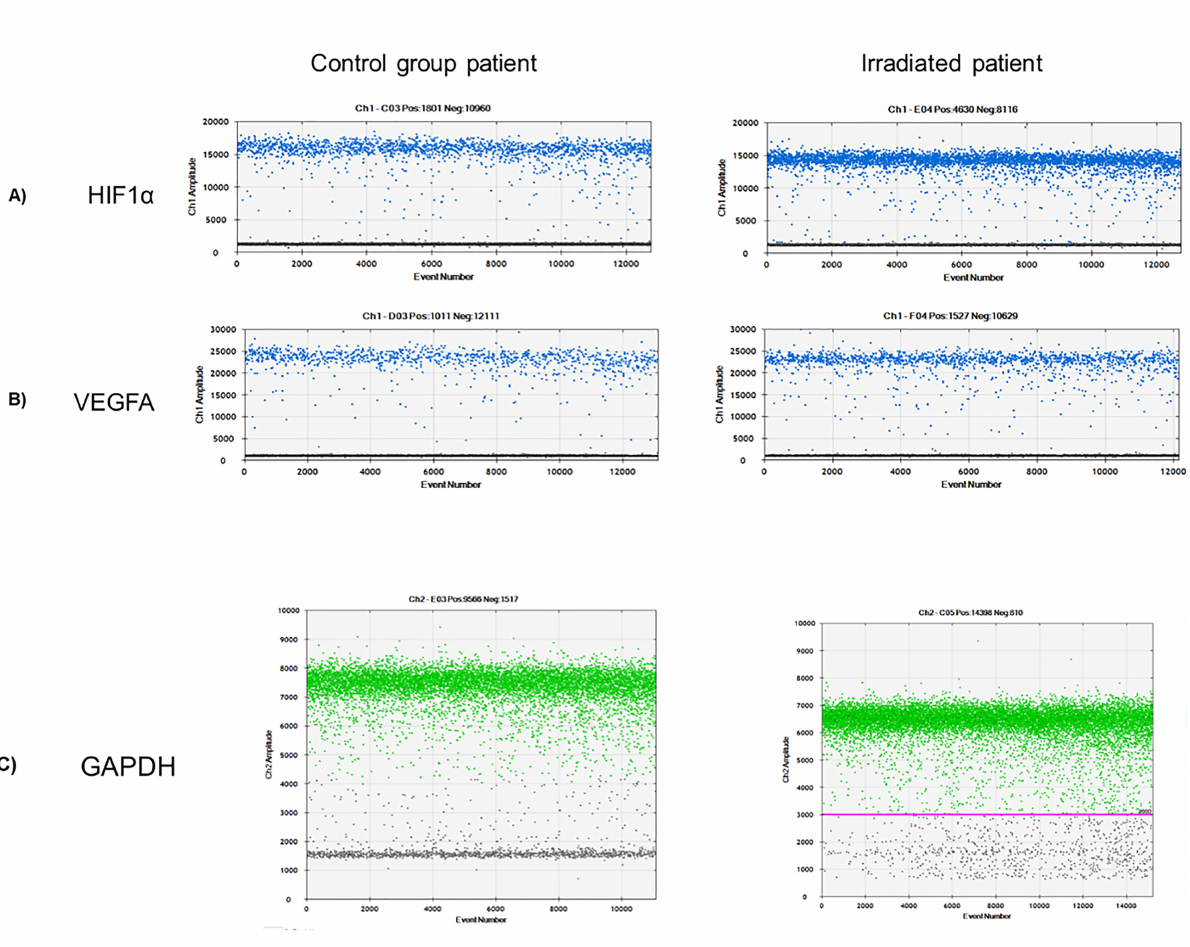
Figure 2 - Graphics of digital PCR in drops. The graphs indicate the fluorescence intensity (Ch1 Amplitude and Ch2 Amplitude for FAM or HEX, respectively) of the drops analyzed (events number). The drops are termed "positive" or "negative" based on their fluorescence amplitudes. Positive events are marked in blue (HIF-1 α and VEGF-A) and green (GAPDH), while negative events in gray (drops without the DNA molecule of interest). All analyzes were performed using QuantaSoft software (Bio- rad). During drop formation cDNA molecules are randomly distributed in the droplets. Due to the high number of independent events, the Poisson algorithm is used to determine absolute quantitation of copy number independent of a standard curve, allowing accurate quantification of gene expression. (A) Expression of HIF1 α in a control group patient (left) and in an irradiated patient (right). (B) Expression of VEGFA in a control group patient (left) and in an irradiated patient (right). (C) Expression of GAPDH in a control group patient (left) and in an irradiated patient